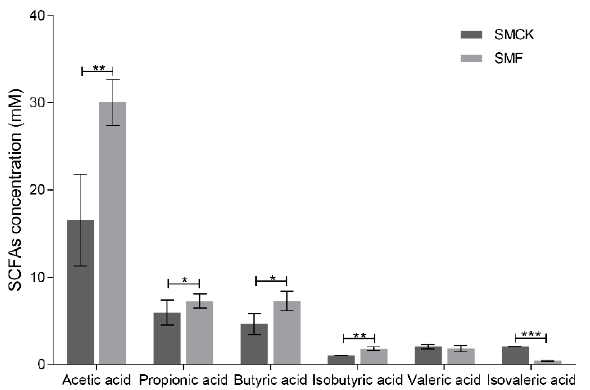
Figure 1. The SCFAs produced by intestinal microbiota after 24 h fermentation. The significantly different results were indicated by specific symbols (*, p < 0.05; **, p < 0.01; ***, p < 0.001).